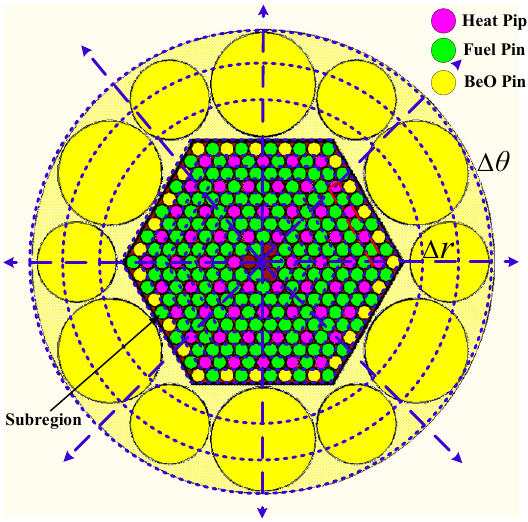
Figure 3. Schematic of 2-D heat conduction model in the HPMR